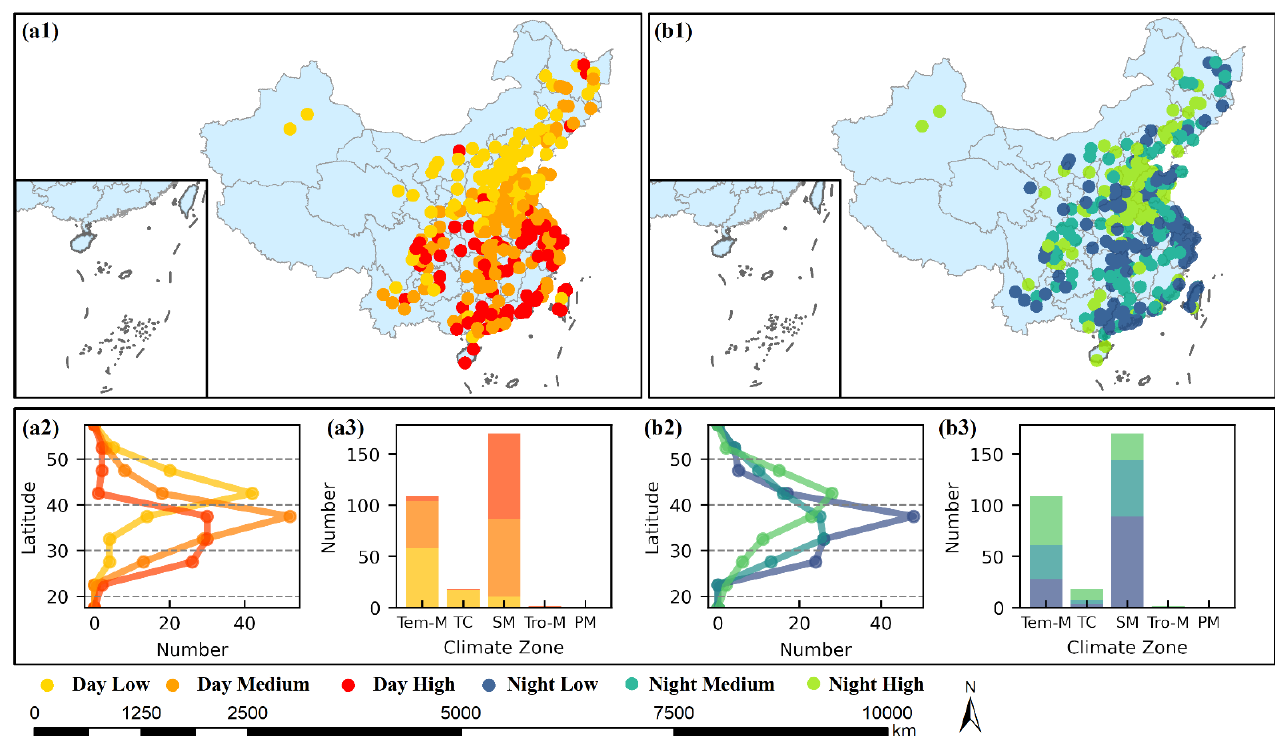
Figure 8. Spatial distribution of the aforementioned three categories at daytime ( a ) and nighttime ( b ). The maps show the spatial distribution of three pattern classifications ( a1 , a2 ). The line plots show their latitudinal variations ( a2 , b2 ). The bar plots show their climate zone-based variations ( a3 , b3 ). Different patterns are represented by colors.